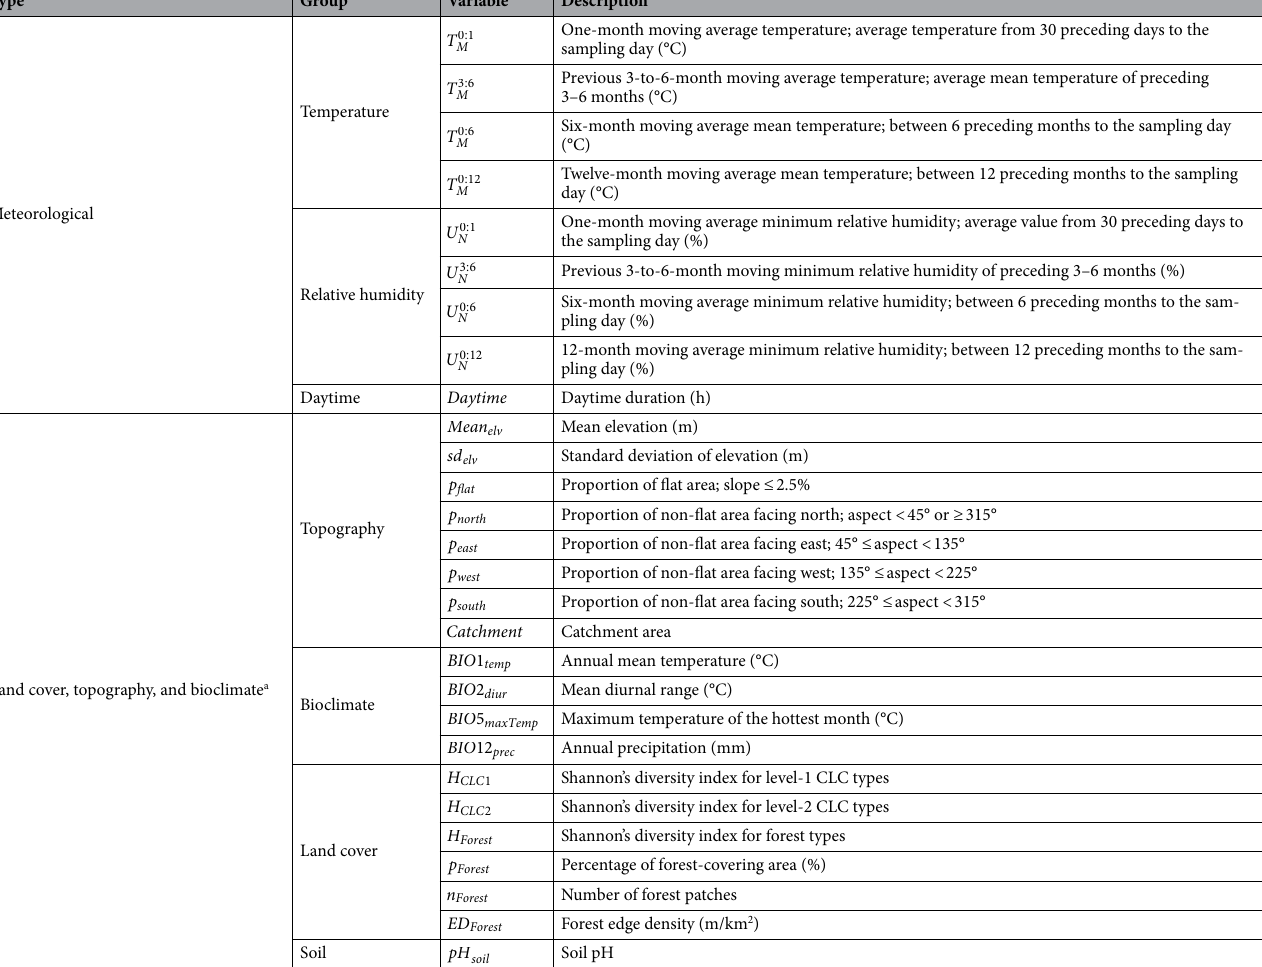
Table 1. Environmental variables (meteorological, land cover, topography, and bioclimatic variables) used to explain I. ricinus nymph counts per 100 m 2 in regression analysis. a Land cover, topography, and bioclimatic variables were transformed by the principal component analysis as coordinates of PCA dimensions before being used in the regression